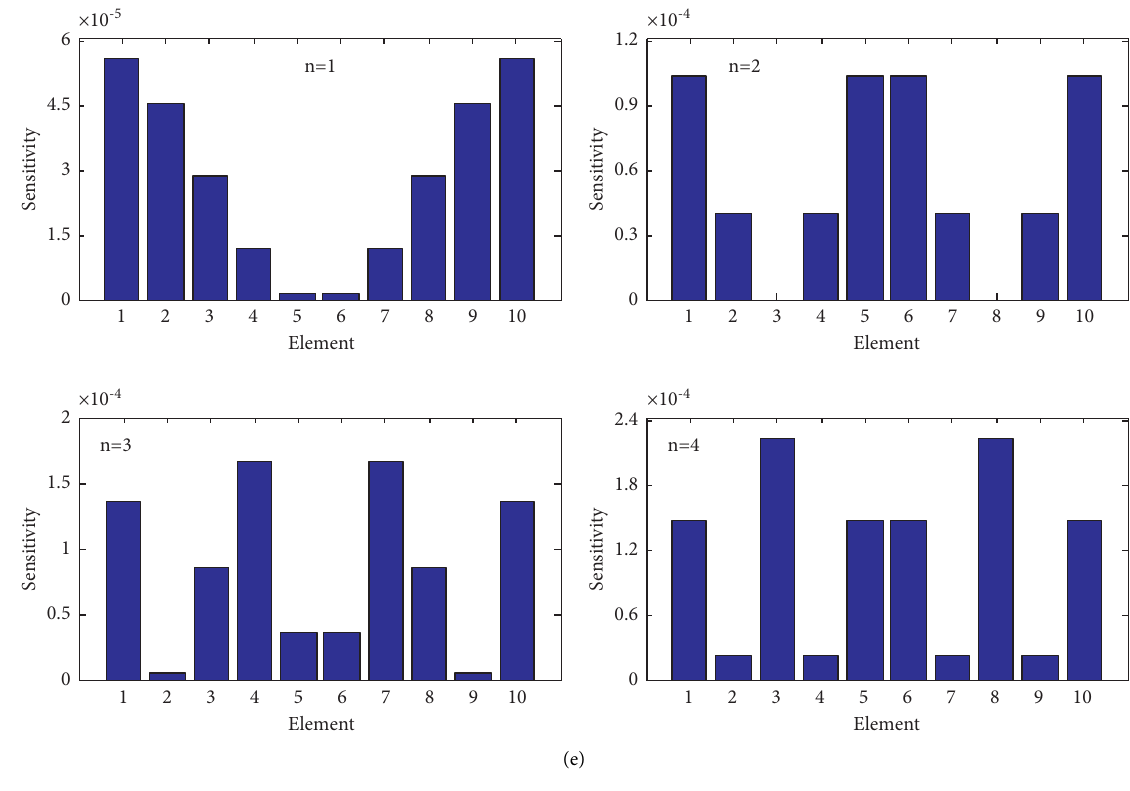
Figure 5: The sensitivity coefficients z z (e) j �